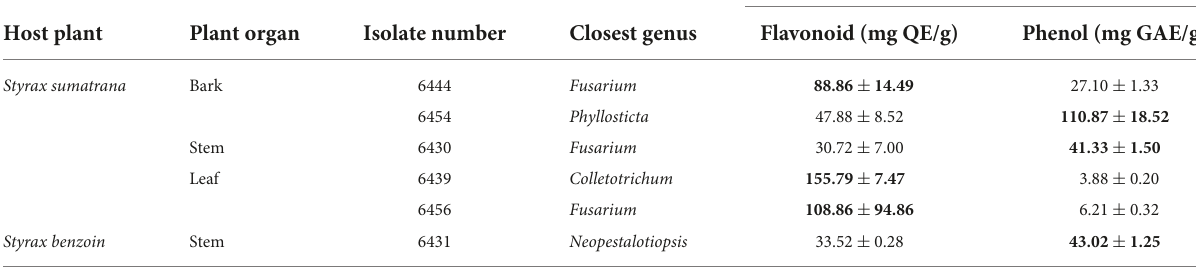
TABLE 3 Fungal isolates with high content of flavonoid by using aluminum chloride assay, and phenol by using Folin–Ciocalteau reagent assay*.